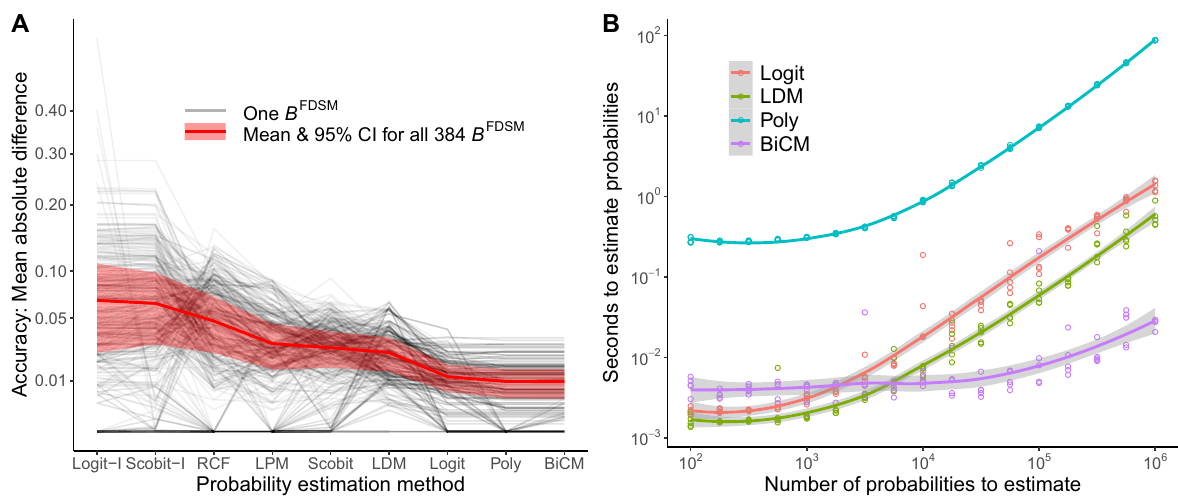
Figure 1. ( A ) Accuracy and ( B ) speed computing p ∗ ik using different methods. Lines show means, while shaded regions show 95% confidence